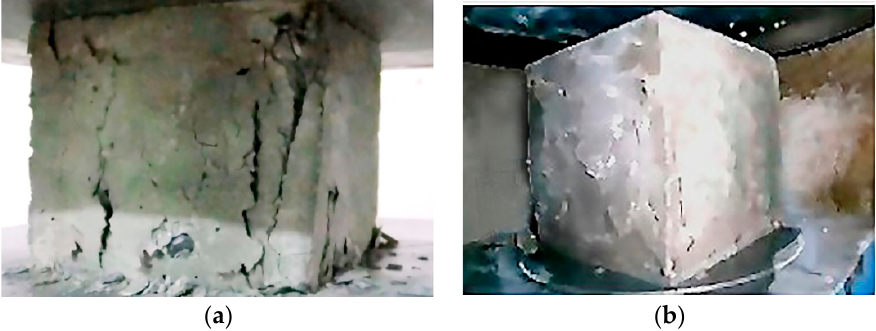
Figure 10. Concrete cube failure ( a ) without wrapping and ( b ) with double wrapping.